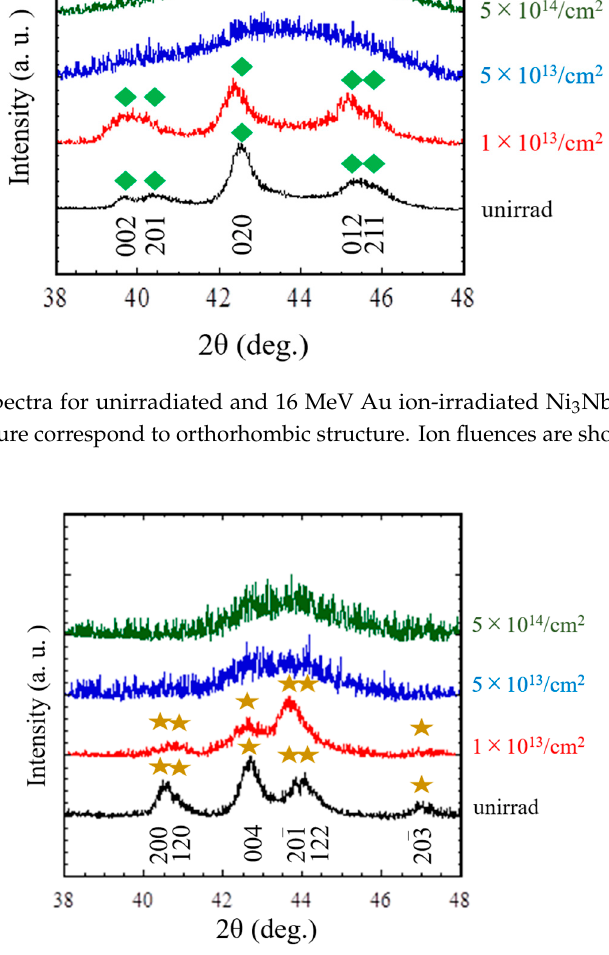
Figure 25. Fourier transformed extended X-ray Absorption Fine Structure (FT-EXAFS) spectra for unirradiated and 16 MeV Au ion-irradiated ( a ) Ni 3 Nb and ( b ) Ni 3 Ta. Figure 26 shows that the increase in hardness of Ni 3 Nb and Ni 3 Ta is accompanied by their amorphization. This result is consistent with the conventional fact that the value of hardness for the amorphous state is larger than that for the crystal state [44,45]. Although the deformation mechanisms of amorphous materials have never been fully understood, a recent review article has discussed their details [46].